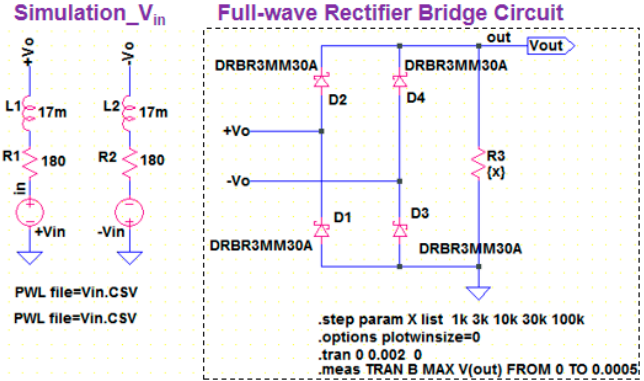
Figure 6. Simulation of full-wave bridge rectifier circuit connected to the Wiegand sensor by LTspice.